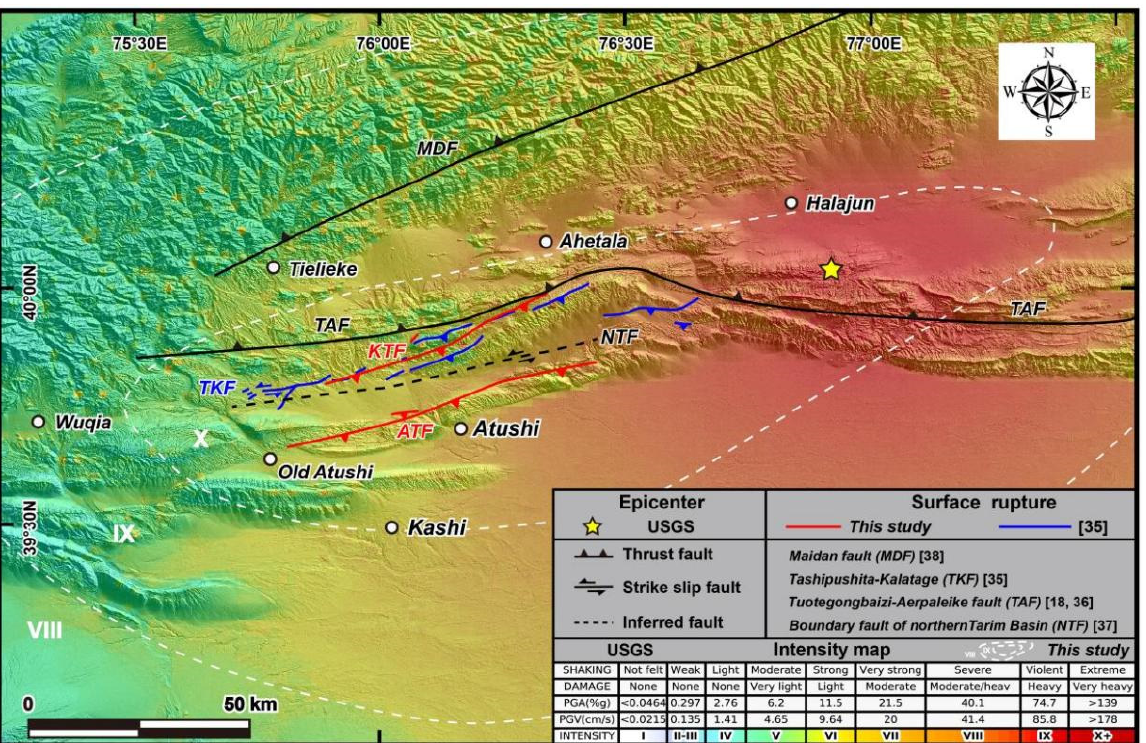
Figure 9. Surface rupture zones and seismogenic faults mapped by our study compared with that given by the previous studies on the 1902 Mw 7.7 Atushi earthquake. The seismic intensity map is produced based on the data from United States Geological Survey (USGS) and [18]. Red and blue lines displaying the spatial distribution of surface rupture zones revealed by this study and [35], respectively.